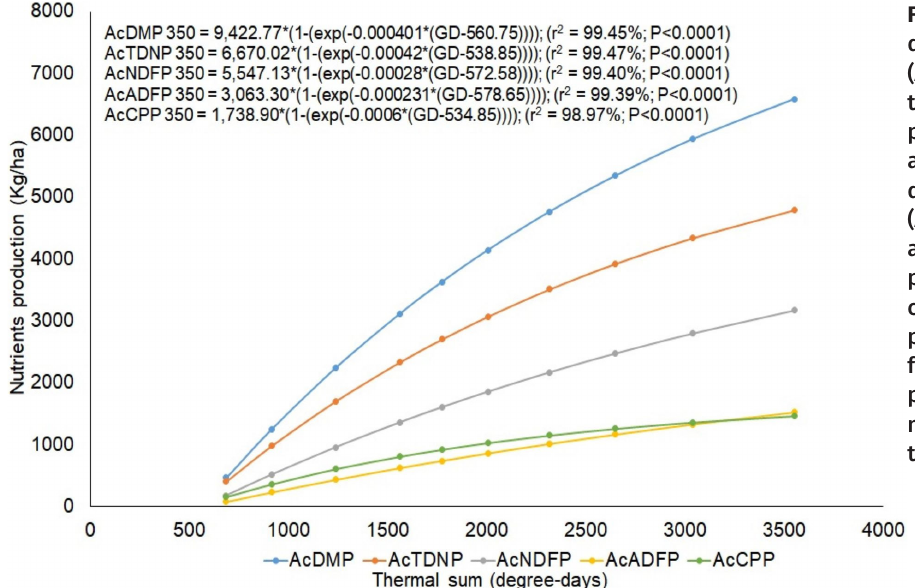
Figure 4. Accumulated dry matter